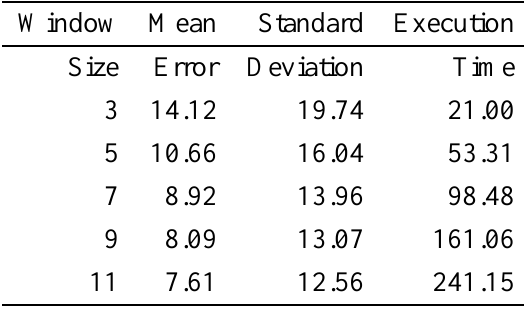
Table 1. Performance measures, Kumar and Chatterji’s algorithm, as a function of the window size.